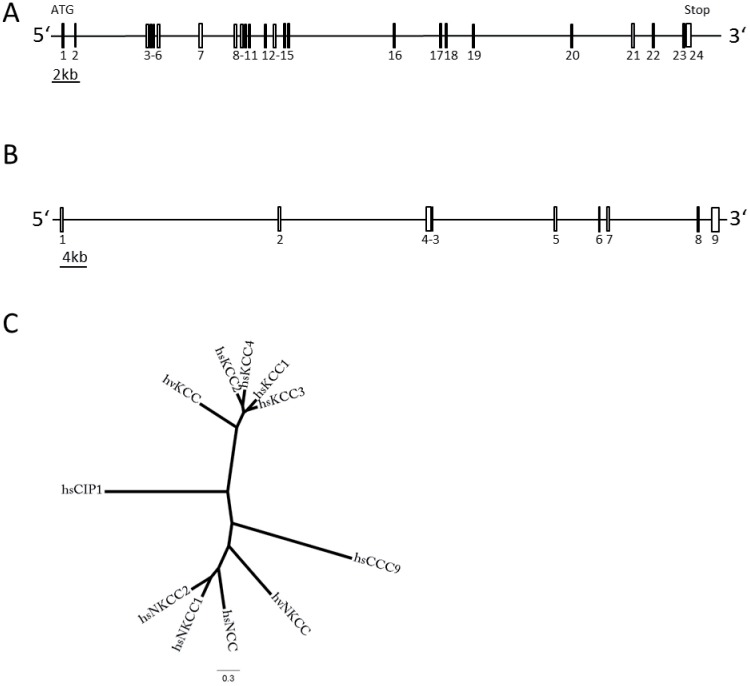
Gene organization and phylogenetic relationship of Hydra vulgaris KCC and N(K)CC.The gene organizations of hvKCC (A) and hvN(K)CC (B) were annotated using part of the genomic sequence of Hydra vulgaris strain 105 data derived from GenBank accession no. NW_004167712.1 and NW_004167444.1). Exons are symbolized by numbered boxes. Introns are horizontal lines between the exons, with lengths of line proportional to number of base pairs. (C) Phylogenetic tree of CCCs was constructed using the Maximum-Likelihood analysis (PhyML, model: Blosum62). The accession numbers are as follows: hsNKCC1 (NP_001037_1), hsNKCC2 (NP_001171761_1), hsNCC (NP_000330.2), hsKCC1 (NP_005063.1), hsKCC2 (NP_065759.1), hsKCC3 (NP_598408.1), hsKCC4 (NP_006589.2), hsCCC9 (NP_078904.3), hsCIP1 (NP_064631.2), hvKCC (XP_012555566.1), and hvN(K)CC (KY646162).